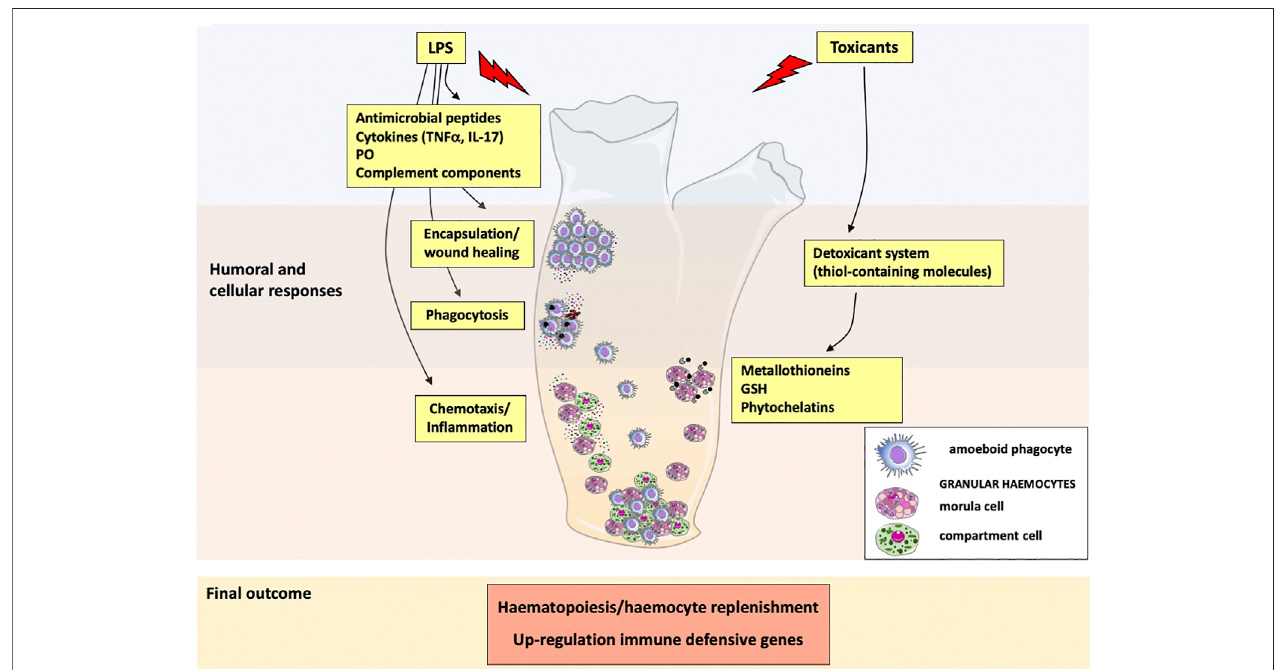
FIGURE 2 | Immune responses and defensive reactions in Ciona robusta . Following exposure to in fl ammatory molecules (LPS), immunocompetent haemocytes are activated, and granular haemocytes release antimicrobial peptides, the cytokines TNF α and IL-17, phenoloxidase and complement components. These molecules participatetocellulardefenceactivities,suchasphagocytosis,encapsulationandwoundhealing,andrecruitotherimmunecellstothesitesofin fl ammation.Exposureto toxicants activates a detoxifying system (thiol-containing molecules) through the direct release of metallothioneins, GSH and phytochelatins by granular haemocytes. Exposure to in fl ammatory/toxic agents modulates the expression of immune-related genes and activates haematopoiesis.